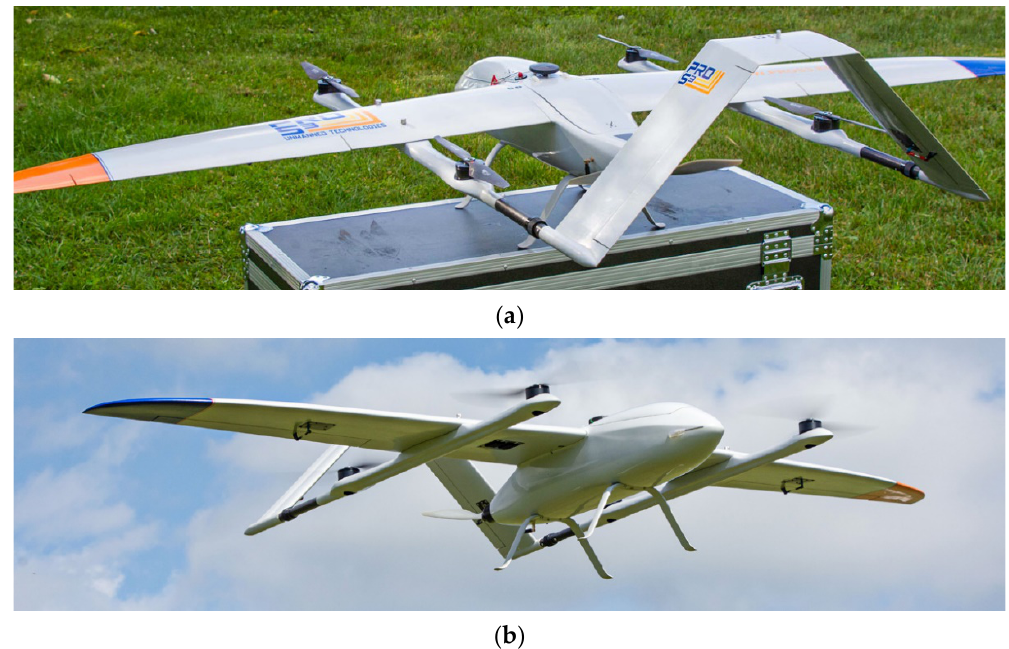
Table 1. Main features of ICON V2.